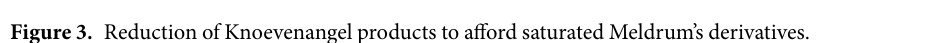
Figure 3. Reduction of Knoevenangel products to afford saturated Meldrum’s